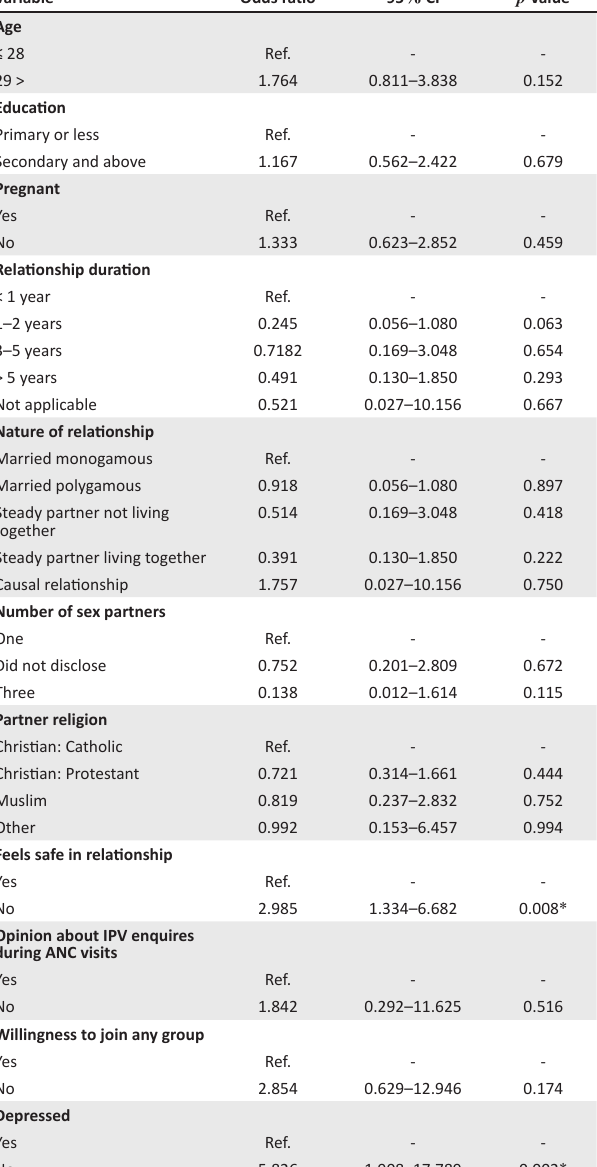
TABLE 5: Multivariate logistic regression model.